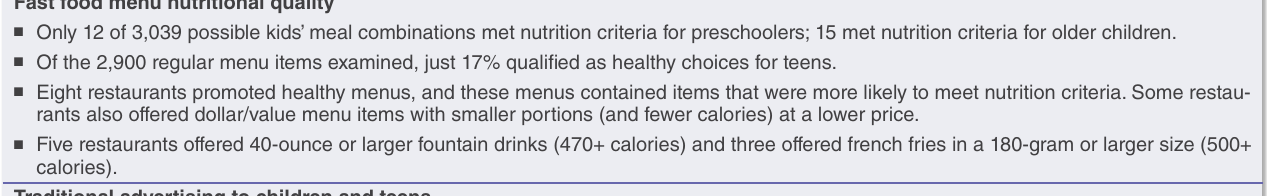
Table 1. Fast Food FACTS 2010: Key findings Fast food menu nutritional